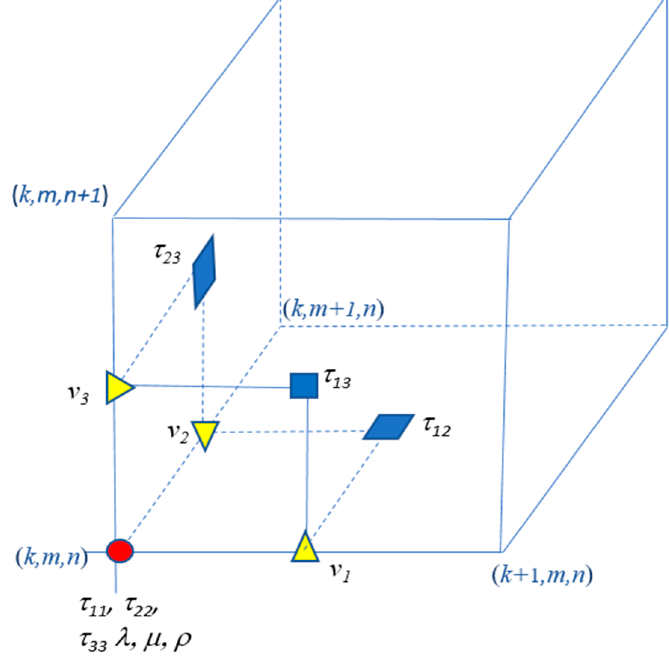
Figure 1. The staggered grid, showing various locations of evaluations.